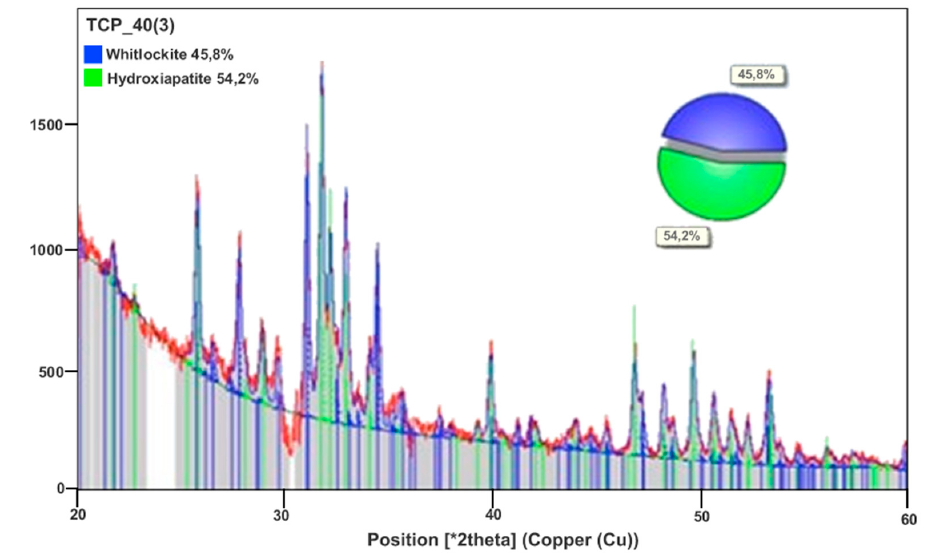
Figure 3. X-ray diffraction pattern (XRD) of the membrane sample. Observe the peaks representing hydroxyapatite and β -TCP. The quantitative analysis showed the presence of two phases: 45.8% β -TCP and 54.2% HA.